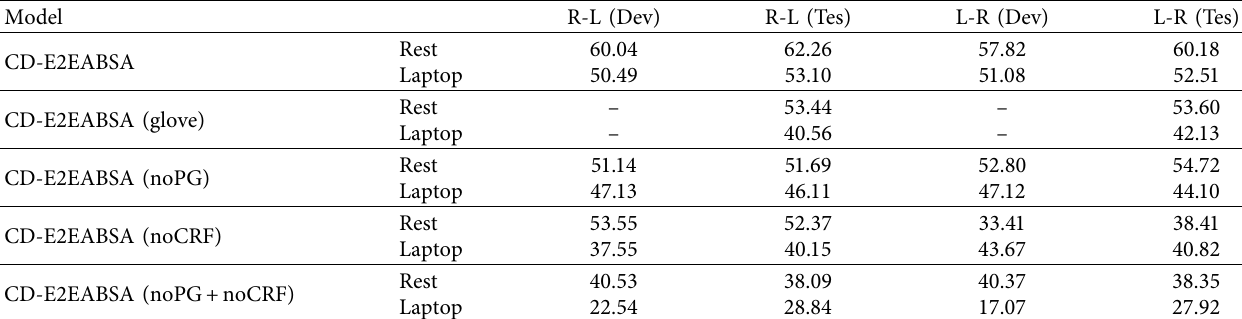
Table 2: Results of models in two cross-domain ABSA tasks. Best scores are in bold.